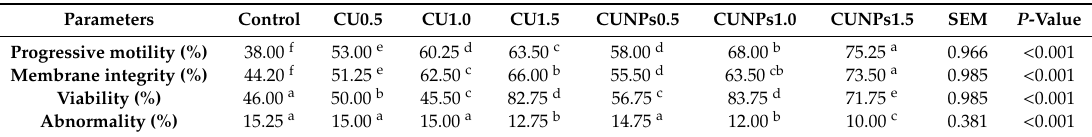
Table 1. Percentage of progressive motility, membrane integrity, viability and abnormality of post-thawed rabbit sperm as a ff ected by graded levels of Curcumin (CU) and Curcumin nanoparticles (CUNPs) (mean ± SEM).